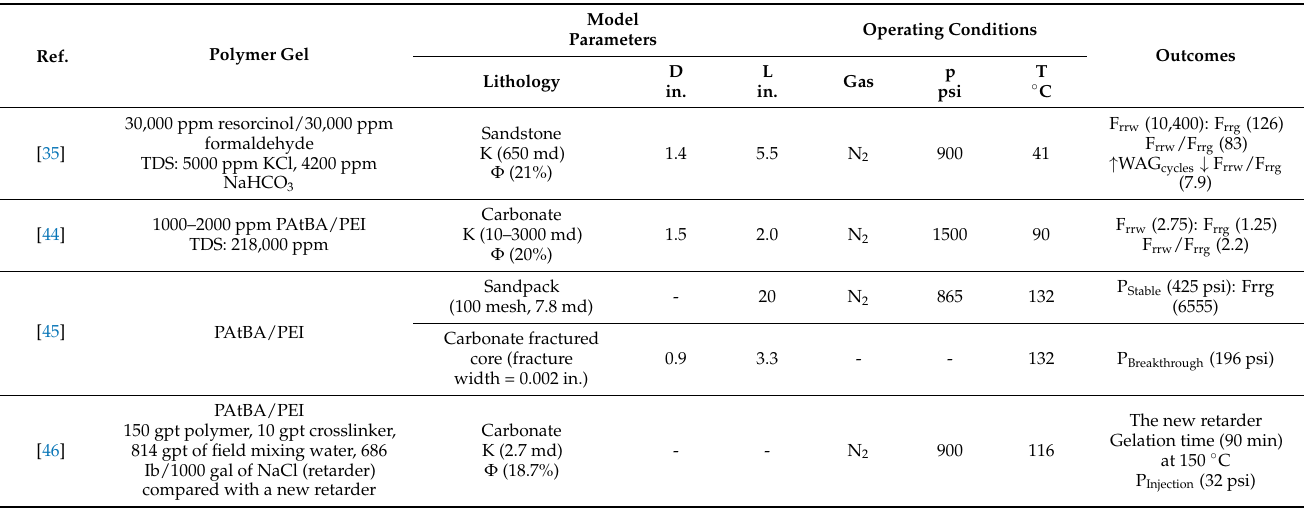
Table 4. Organically crosslinked polymer gels—lab evaluation.